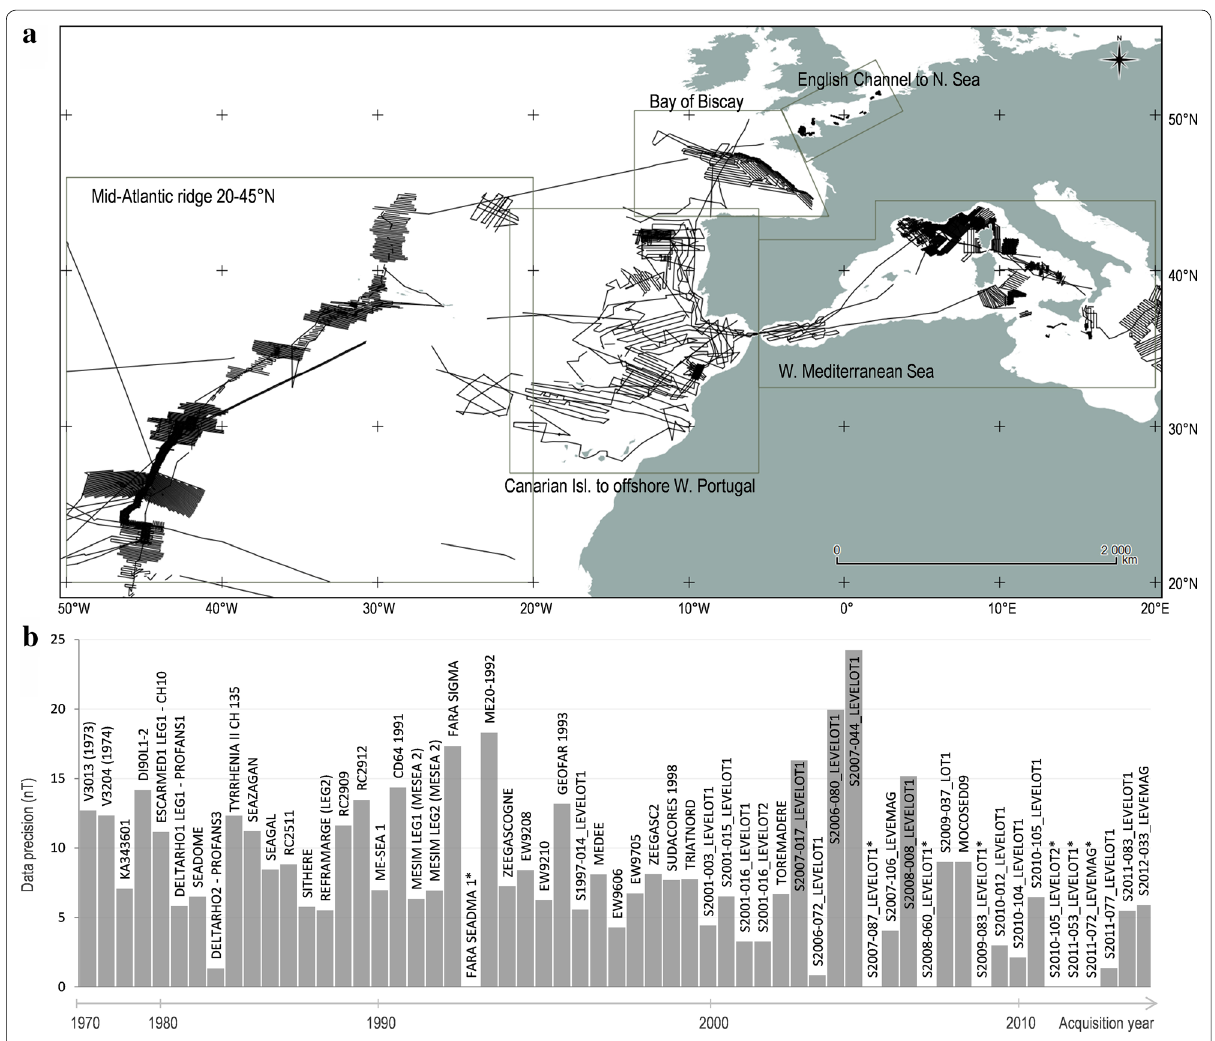
Fig. 2 Marine datasets used in the study. a Map showing the areas of interest selected for statistics with models (see Table 3). b Summary diagram showing selected datasets sorted by acquisition year (in abscissa). The data precision estimated by differences at crossover points is indicated in ordinate. The precision of the datasets marked with a star is undetermined (mainly due to a lack of crossover points), but estimated to be lower than 30 nT